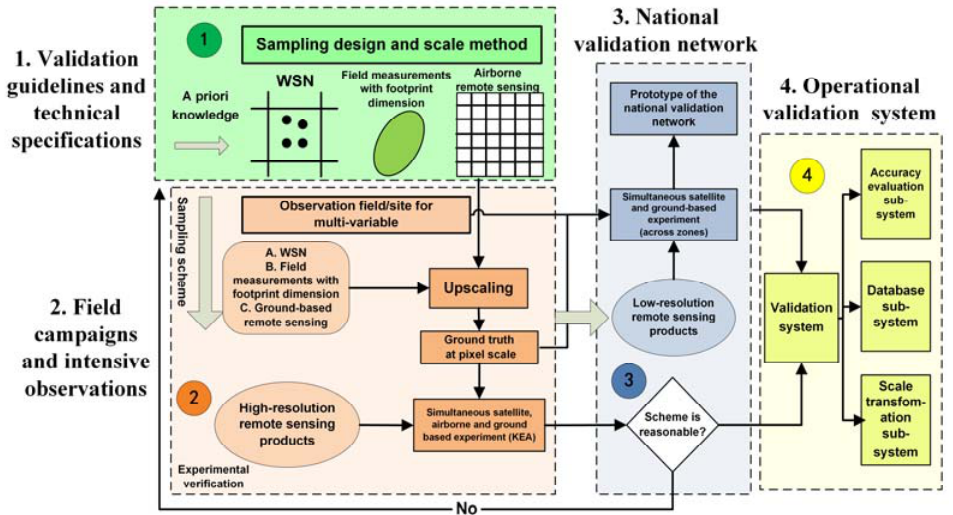
Figure 1. The overall validation strategy. WSN stands for wireless sensor network.